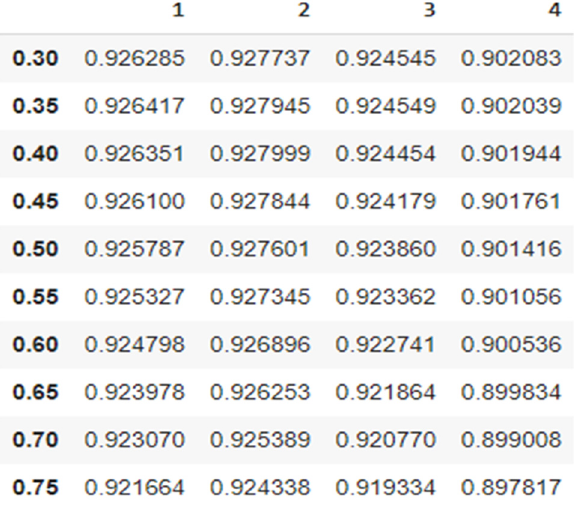
Table 5. Fourfold cross-validation results of the Infection segmentation model calculated as the mean of folds.